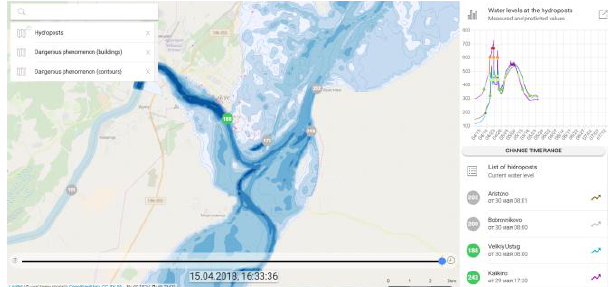
Figure 2. System web interface with a time